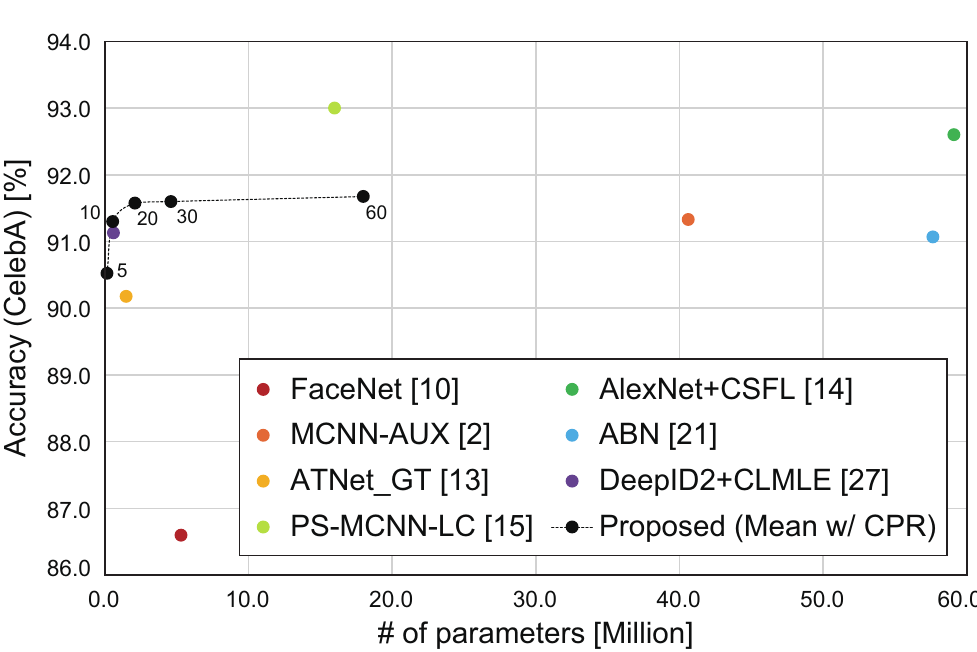
Figure 9. Comparison of the parameter efficiency of face attribute estimation methods. The numbers near each point in the graph indicate the hyperparameter c